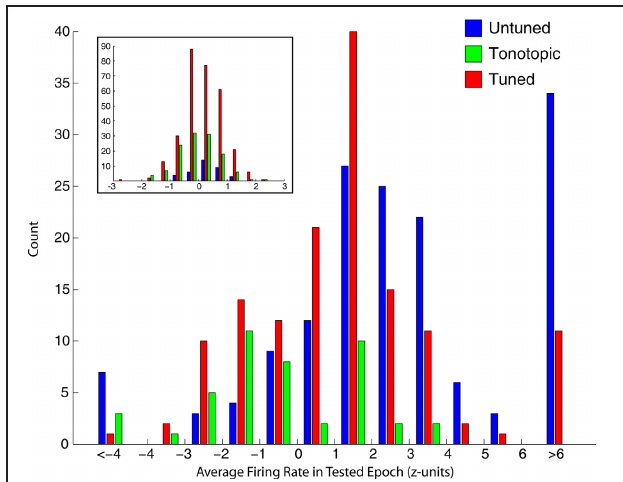
FIGURE 7 | Strength of visual responses in tonotopic, tuned, and untuned recording penetrations. For each of the four epochs tested for visual responses, we computed the average firing rate (normalized in standard deviation units of baseline). This histogram shows the distribution of firing rates across all temporal windows in visually responsive recordings, for each of the auditory penetration categories. Visually responsive sites along untuned (blue) and tuned (red) recording penetrations showed responses of greater magnitude, and were typically excitatory. In contrast, tonotopic penetrations (green) contained sites that showed only small changes in firing rate, and were frequently inhibitory. The inset shows histograms of sites not categorized as visually sensitive, firing rate in sites marked as unresponsive was normally distributed around